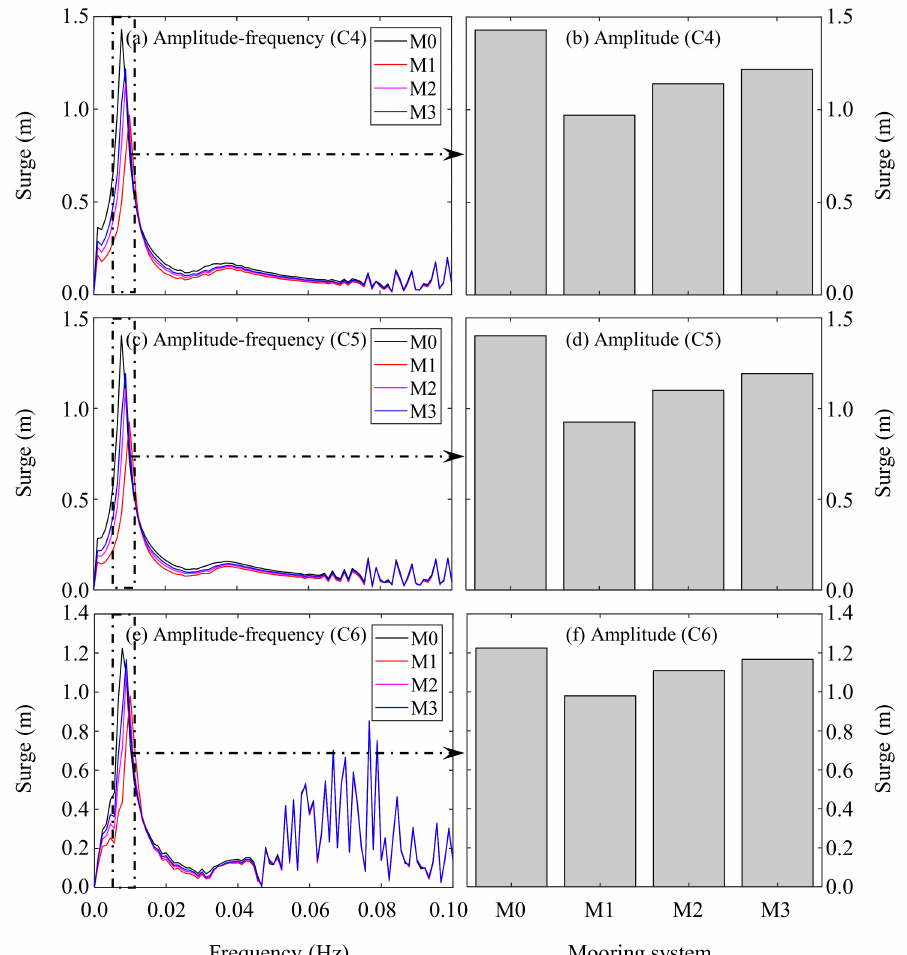
Figure 12. Wind turbine surge movement in frequency domain with M0–3 when under: ( a ) amplitude- frequency (C4); ( b ) amplitude (C4); ( c ) amplitude-frequency (C5); ( d ) amplitude (C5); ( e ) amplitude- frequency (C6); ( f ) amplitude